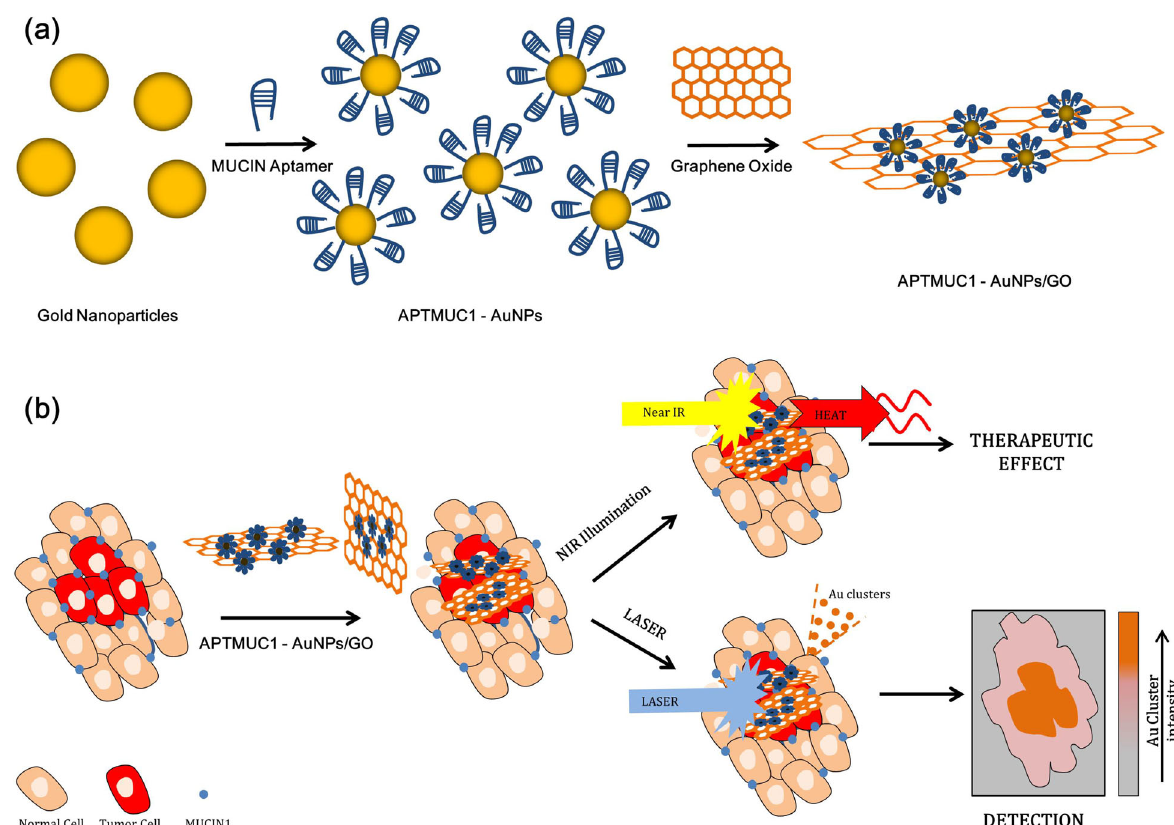
Fig. 9 Aptamer – AuNP – GO nanocomposites for mucin detection. a Apt – AuNPs/GO hybrid nanoparticles matrix complex: a First AuNPs are functionalized with aptamer (Apt – AuNPs) and then mixed with GO to obtain Apt – AuNP – GO hybrid nanoparticles. b Apt – AuNP – GO hybrid material is then surface immobilized with MUC1-positive breast tumor cells. Irradiation with NIR Laser light for photothermal therapy results in targeted inhibition of breast cancer MCF-7 cell growth. Coupling the AptMUC1 – AuNPs/GO hybrid material with laser desorption for tumor tissue imaging helps the detection of tumor cells by observing Au cluster ions. Adapted with permission from ref. 82 Copyright 2015, American Chemical Society, and ref. 86 Copyright 2015, Springer